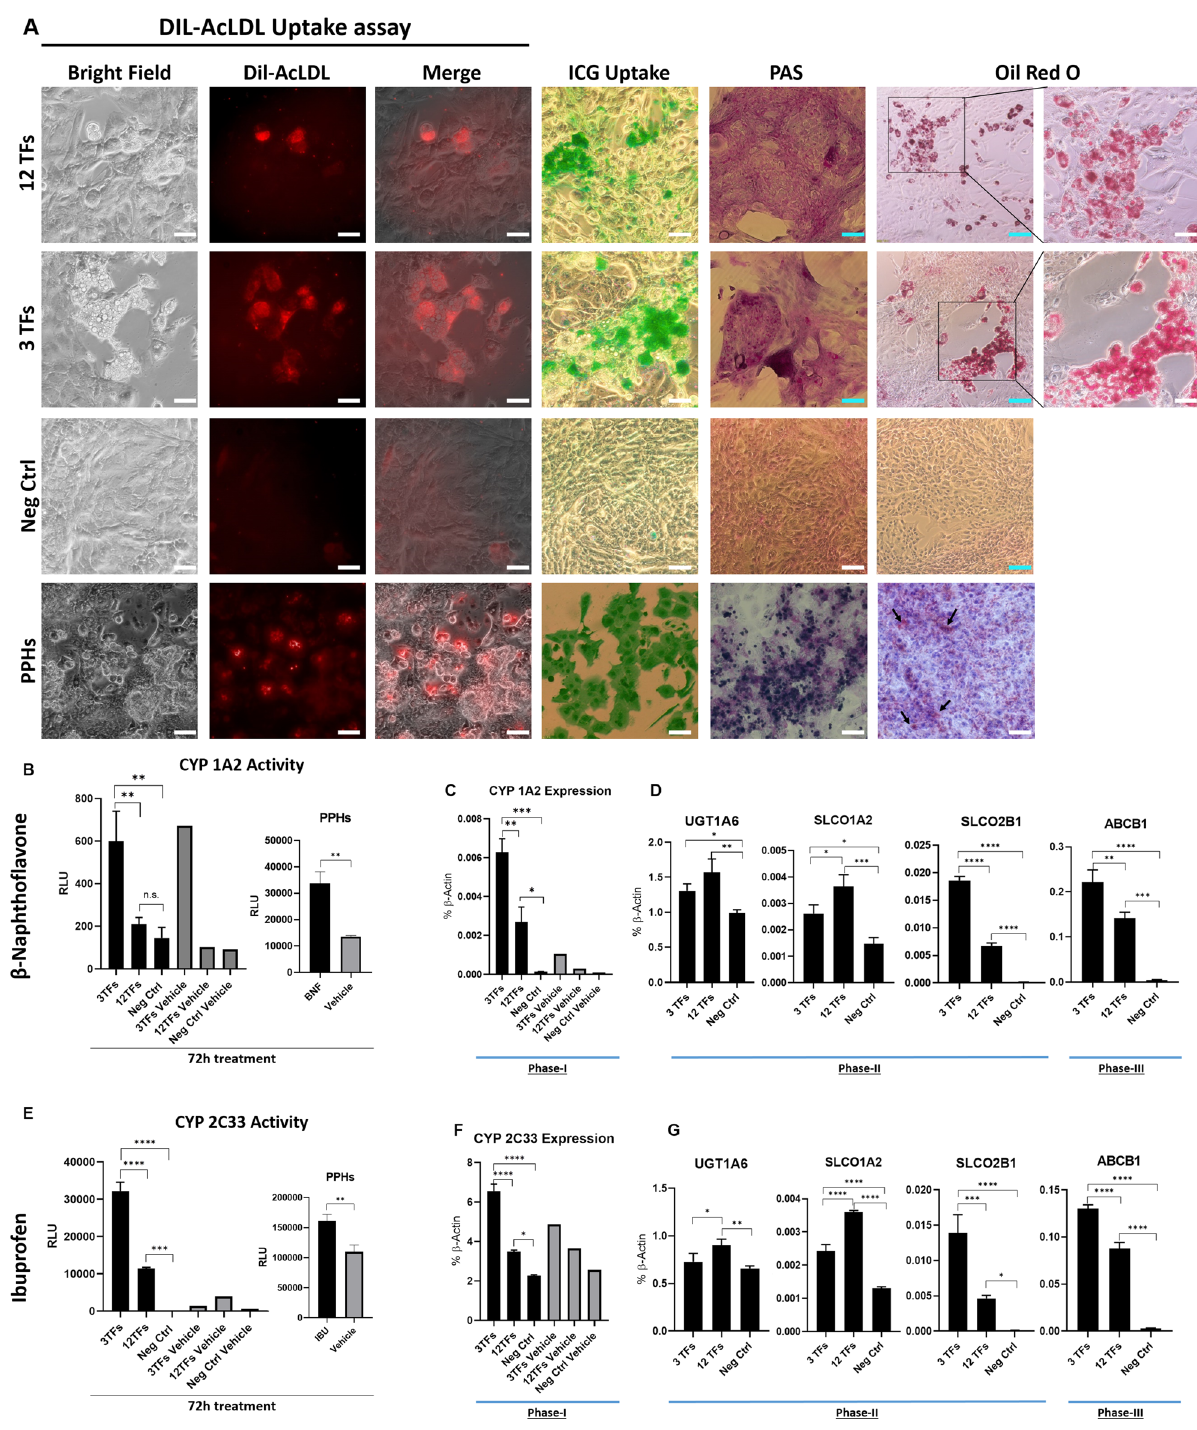
Figure 6. Functional analysis of 3TFs-piHeps. ( A ) From left to right: fluorescence pictures of Dil-AcLDL uptake assay (bright field, + 10 µg/mL conjugated Dil-AcLDL—Excitation 554 nm; and merge); bright field pictures of ICG uptake (1 mg/mL), PAS Staining’s and Oil Red O. White scale bars 50 µm and blue scale bars 100 µm. From top to bottom, cells transduced with 12TFs, 3TFs, Neg-Ctrl at day 15 p.t., and PPHs. ( B,E ) CYP450 assay normalized relative light unit (RLU) of luciferin showing CYP1A2 induction by 25 µM BNF and CYP2C9 (CYP2C33) induction by 500 µM IBU in piHeps, Neg-Ctrl and PPHs. ( C,F ) confirmation of CYP1A2 and CYP2C33 gene expression levels by qRT-PCR. In pigs, the homologue gene for CYP2C9 is CYP2C33 . ( D,G ) Gene expression pattern of Phase-II and Phase-III of drug metabolizing genes UGT1A6 , SLCO1A2 , SLCO2B1 and ABCB1 were analyzed in 3TF-piHeps; 12TF-piHeps and Neg-Ctrl treated with BNF or IBU. All piHeps CYP450 data were obtained at day 16 post-transduction and analyzed using one-way ANOVA, with Tukey’s post-test, except for CYP induction in PPHs, where Unpaired t -test two-tailed was used. Significance from n = 3 independent values is displayed as *p < 0.05; ****p ≤